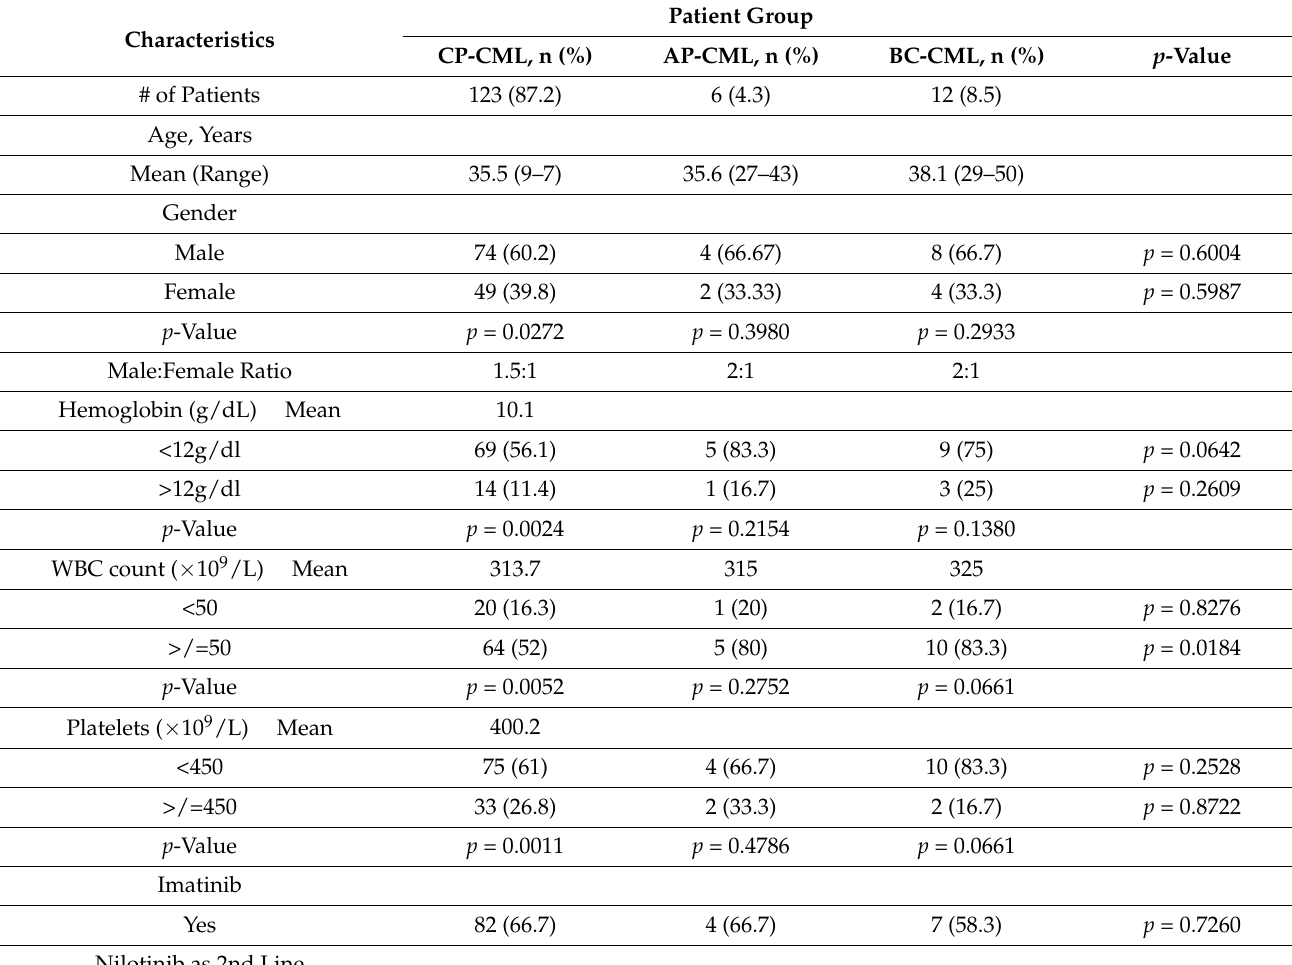
Table 4. Comparison of demographics, clinical data and laboratory parameters between three phases of